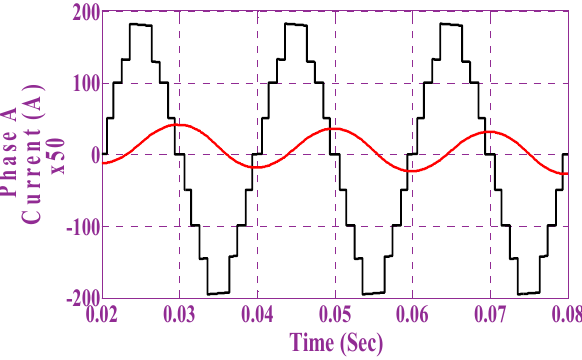
Figure 11. Phase voltage and current for the nine-level SCMLI with RL load.